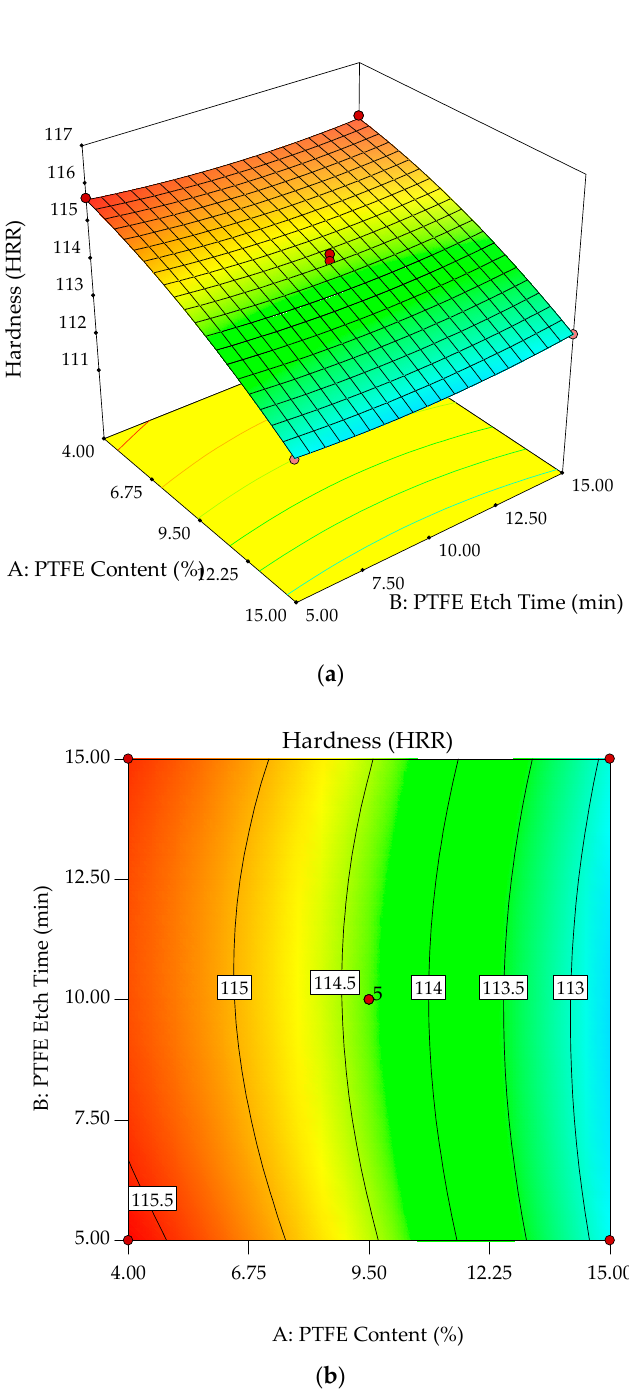
Figure 11. 3D response surface plot ( a ) with 2D contour plot; ( b ) of the effects of PTFE content and PTFE etch time on hardness of POM composites.